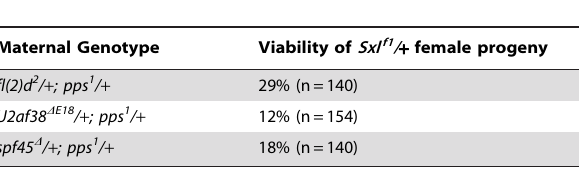
Table 1. Lethal interactions between Sxl f1 , pps 1 , and mutations in core spliceosomal